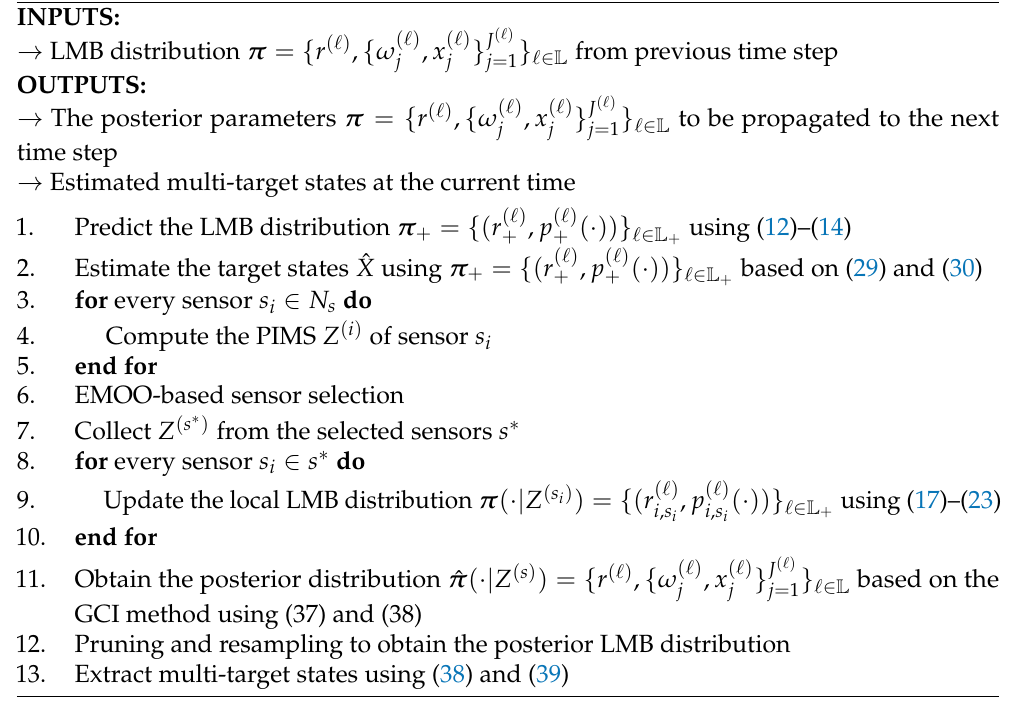
Figure 6. Schematic diagram of sensor selection with LMB filtering. Algorithm 3 Step-by-step pseudocode for the proposed approach with LMB filtering, sensor selection, and